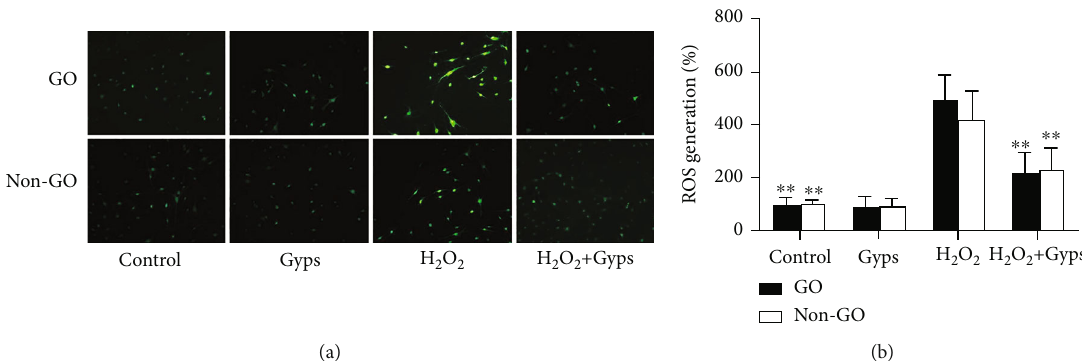
Figure 7: E ff ect of gypenosides on the activity of superoxide dismutase induced by H level of reactive oxygen species in orbital fi broblasts of GO patients under H requirements of the group. The orbital fi broblasts of GO patients in each treatment group were localized in situ by ROS fl uorescence intensity, and then, (a) was photographed by fl uorescence microscope. And the fl uorescence values of each group of ROS were detected after the excitation light and emission light were adjusted by full-wavelength enzyme labeling instrument. The result is expressed as a percentage of unprocessed control values. Three samples from each of the three GO and non-GO donors were taken for the experiment. All detections are repeated 3 times, with 3 replicate wells each time ( ∗ as P < 0 : 05 and ∗∗ as P < 0 : 01 ; P < 0 : 05 means the di ff erence is statistically signi fi cant, and P value is analyzed by two-way